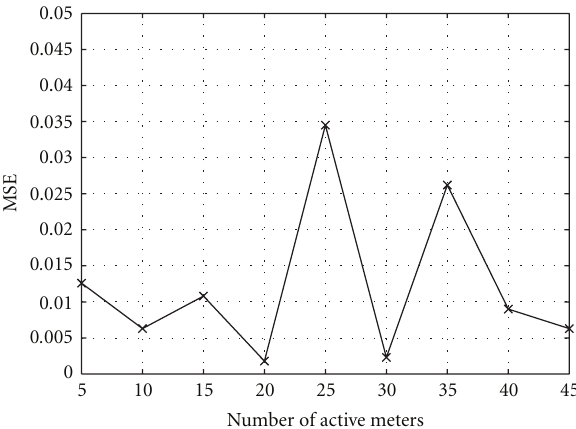
Figure 10: MSE achieved by BCS for di ff erent number of active meters.